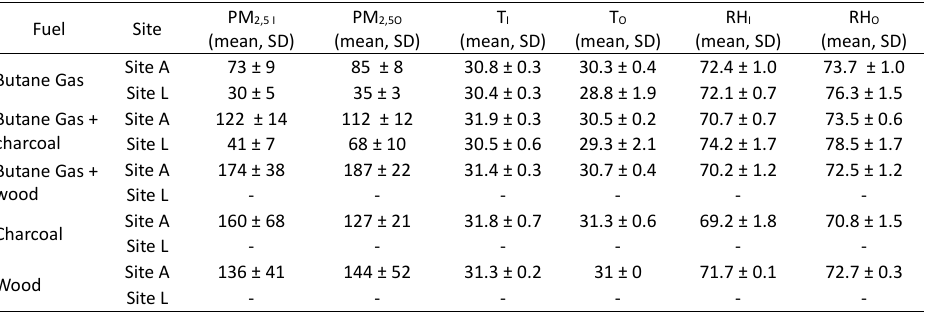
Table 4: Daily average concentrations of PM 2.5 (µg/m 3 ), temperature (T, °C) and relative humidity (RH, %) in indoor and outdoor air for hundred Table 4. Daily average concentrations of PM (µg/m 3 ), temperature (T, °C) and relative humidity (RH, %) in indoor and 2.5 and four housing outdoor air for hundred and four